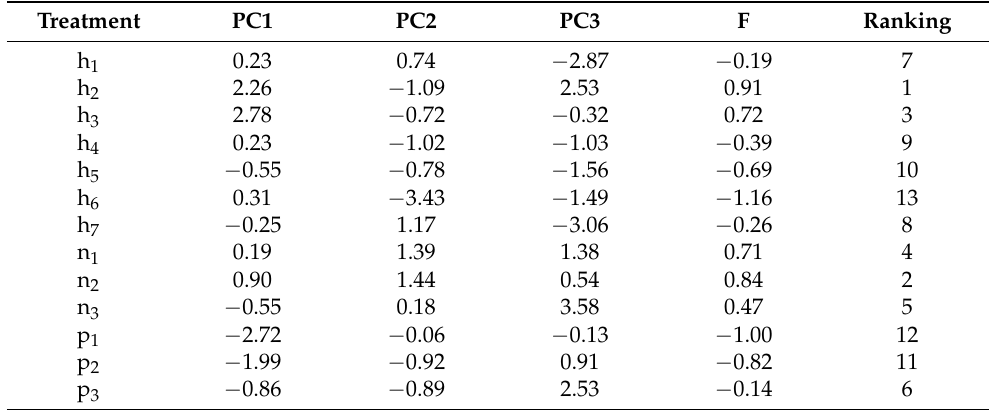
Table 6. Principal component scores, comprehensive scores, and ranking of physiological growth of jujube trees under 13